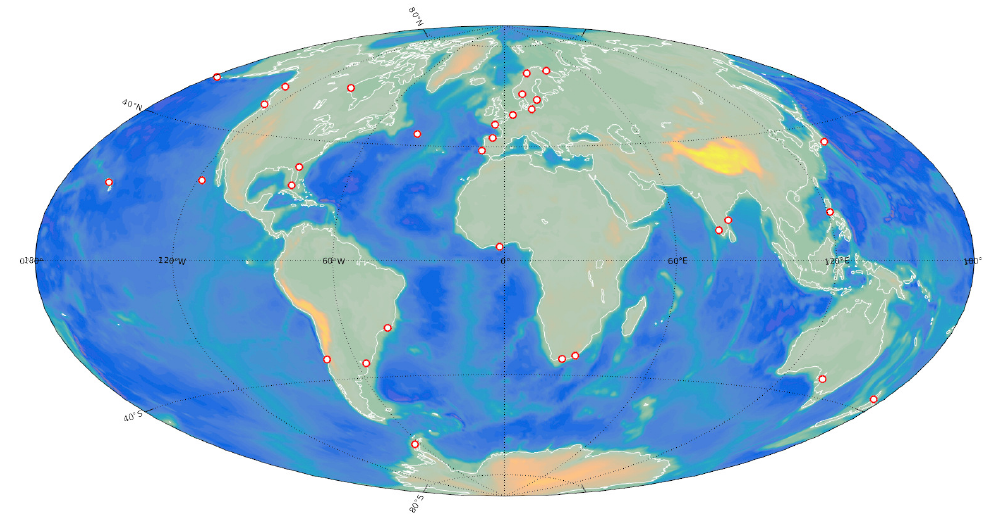
Figure 2. Map showing the locations of tides gauges used to build the GSLTG series.